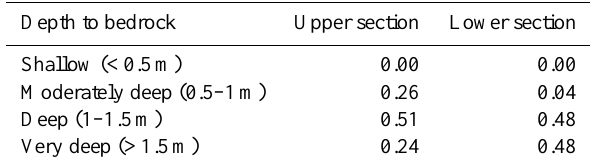
Table 4. Frequency distribution of bedrock depth measurements along GPR transect (Fig.